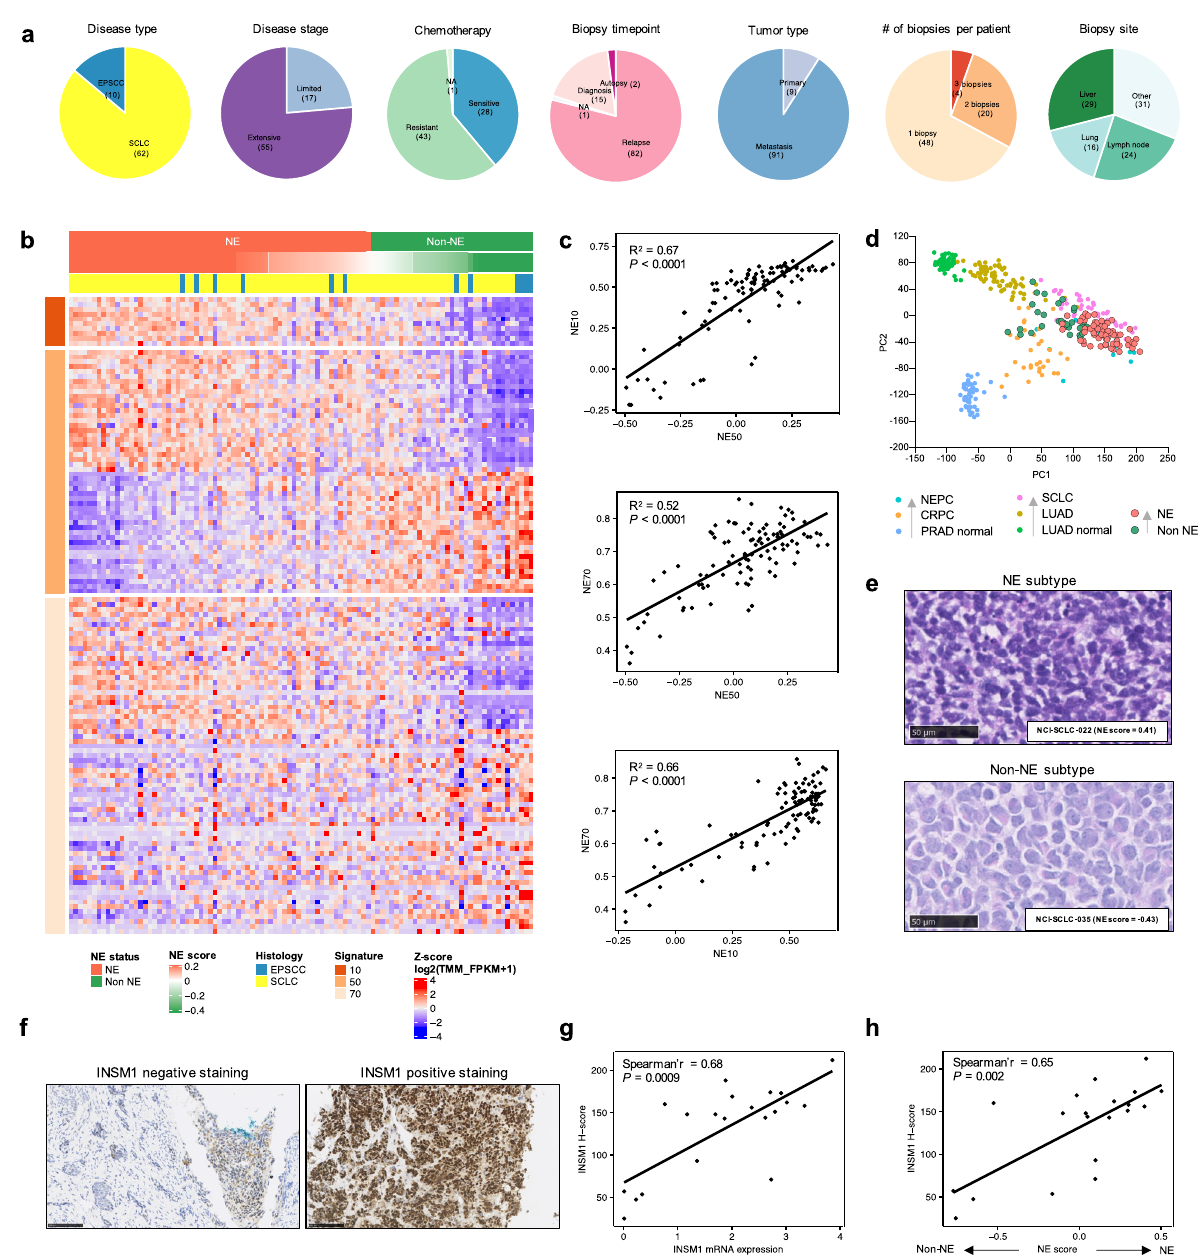
Fig. 1 Neuroendocrine differentiation de fi nes distinct SCNC subtypes. a Pie charts summarizing patient and biopsy characteristics. b Heatmap of the 10- gene 16 (top panel), 50-gene 15 (middle panel), and 70-gene (lower panel) 17 neuroendocrine signatures. The 50-gene signature was derived from differentially expressed genes between matched normal adrenal cortex and medulla, 25 genes each correlating positively and negatively with neuroendocrine differentiation. The 70-gene and 10-gene signatures were derived from resistant prostate cancers with small cell or neuroendocrine features. Neuroendocrine scores and subtypes (NE or non-NE) derived from the 50-gene signature, and histology are indicated above the heatmap. c Pearson correlation between the three neuroendocrine signatures. R-squared values and the P -values are indicated ( P < 2.2e-16). d Projection of 100 SCNC tumors onto the PCA developed by Balanis et al. 8 , to evaluate the degree of neuroendocrine differentiation (trajectory indicated by arrows). e Representative photomicrograph images of H&E-stained small cell lung cancer of NE and non-NE subtypes. Black bars represent 50 μ m (observations were repeated independently two times). f Representative images of IHC staining for INSM1 (observations were repeated independently two times). g Spearman correlation between INSM1 mRNA level and INSM1 H-score ( n = 20 tumors). h Spearman correlation between 50-gene neuroendocrine signature score and INSM1 H-score ( n = 20 tumors). All tests are two-tailed. Abbreviations: NE Neuroendocrine differentiation; SCLC Small cell lung cancer; EPSCC Extrapulmonary small cell cancer; TMM Trimmed Mean of M-values; FPKM Fragments Per Kilobase of Exon Per Million Fragments Mapped; H&E Hematoxylin and Eosin; NEPC neuroendocrine prostate cancer; CRPC castration-resistant prostate cancer; PRAD prostate adenocarcinoma; LUAD lung adenocarcinoma; PCA principal component analysis; NA not assessed.